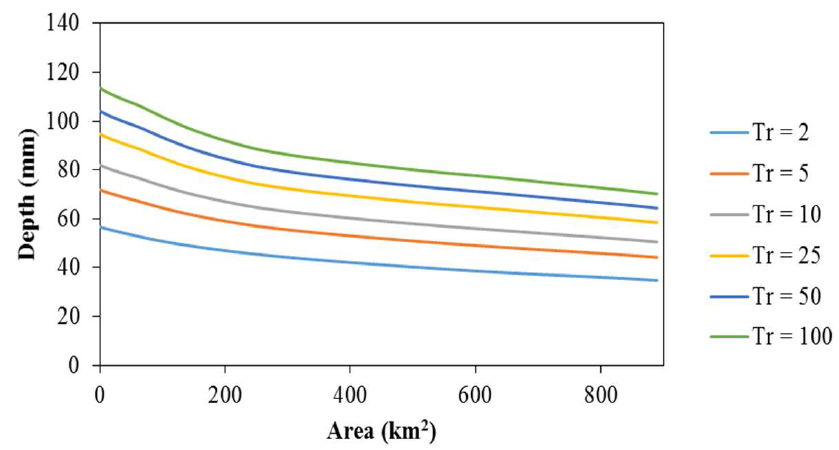
Figure 4. DADF curves for the historical period (1960 to 1989).